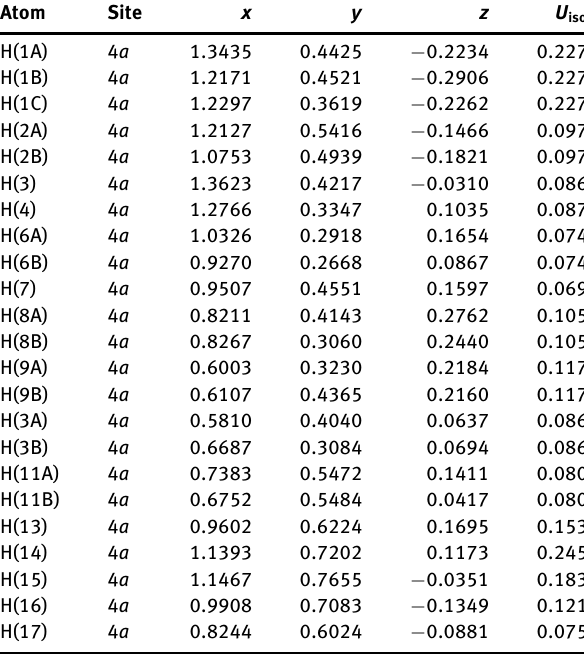
Table 2: Fractional atomic coordinates and isotropic or